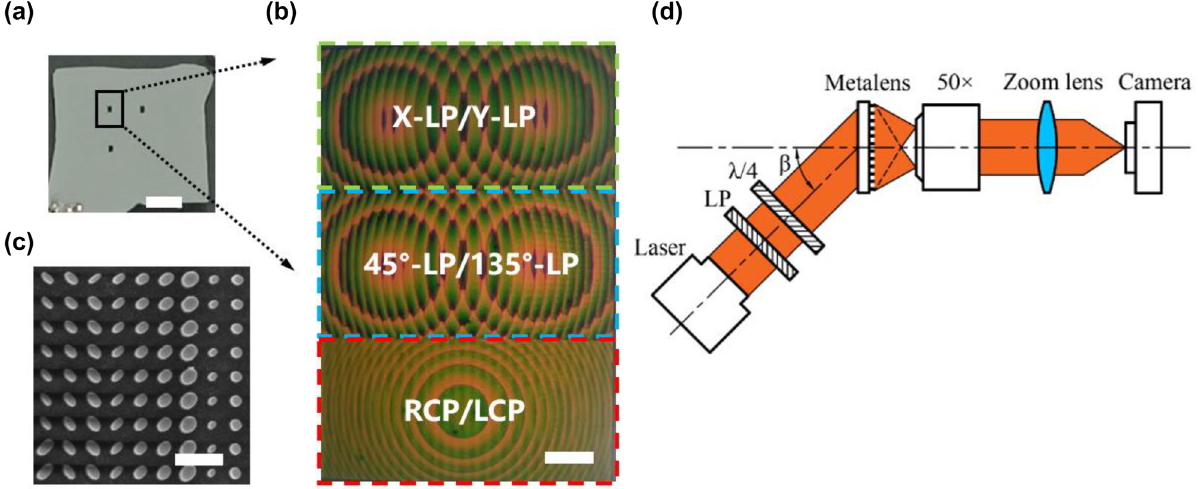
Figure 4: Manufactured BCEM sample and its test optical path. (a) Photograph of the BCEM sample. Scale bar: 1 mm. (b) Microscopic image of the sub eye, which consists of three bifocal metalenses. Three bifocal metalenses decompose the light into X-LP and Y-LP, 45 ◦ -LP and 135 ◦ -LP, RCP, and LCP, respectively. Scale bar: 20 μ m. (c) SEM image of the bionic compound eye metasurface. Scale bar: 600 nm. (d) Schematic diagram of the optical path for testing the focusing performance of the BCEM. Where LP and λ /4 denote line polarizer and quarter-wave